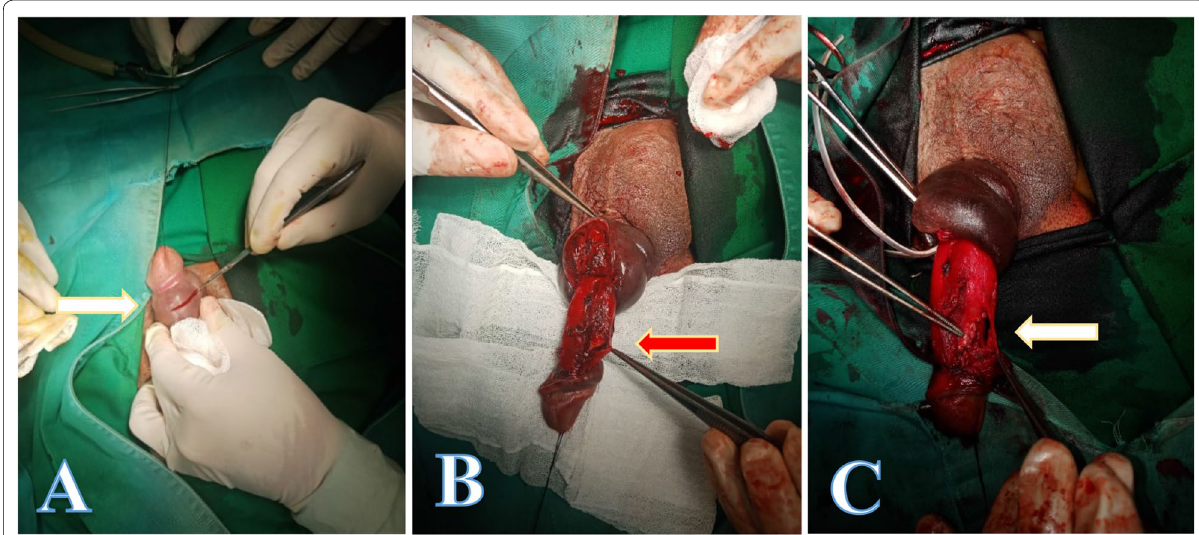
Fig. 2 a Surgical exploration via subcoronal incision. b Degloving incision and a defect of around 2 tunica albuginea. c Repaired tunica